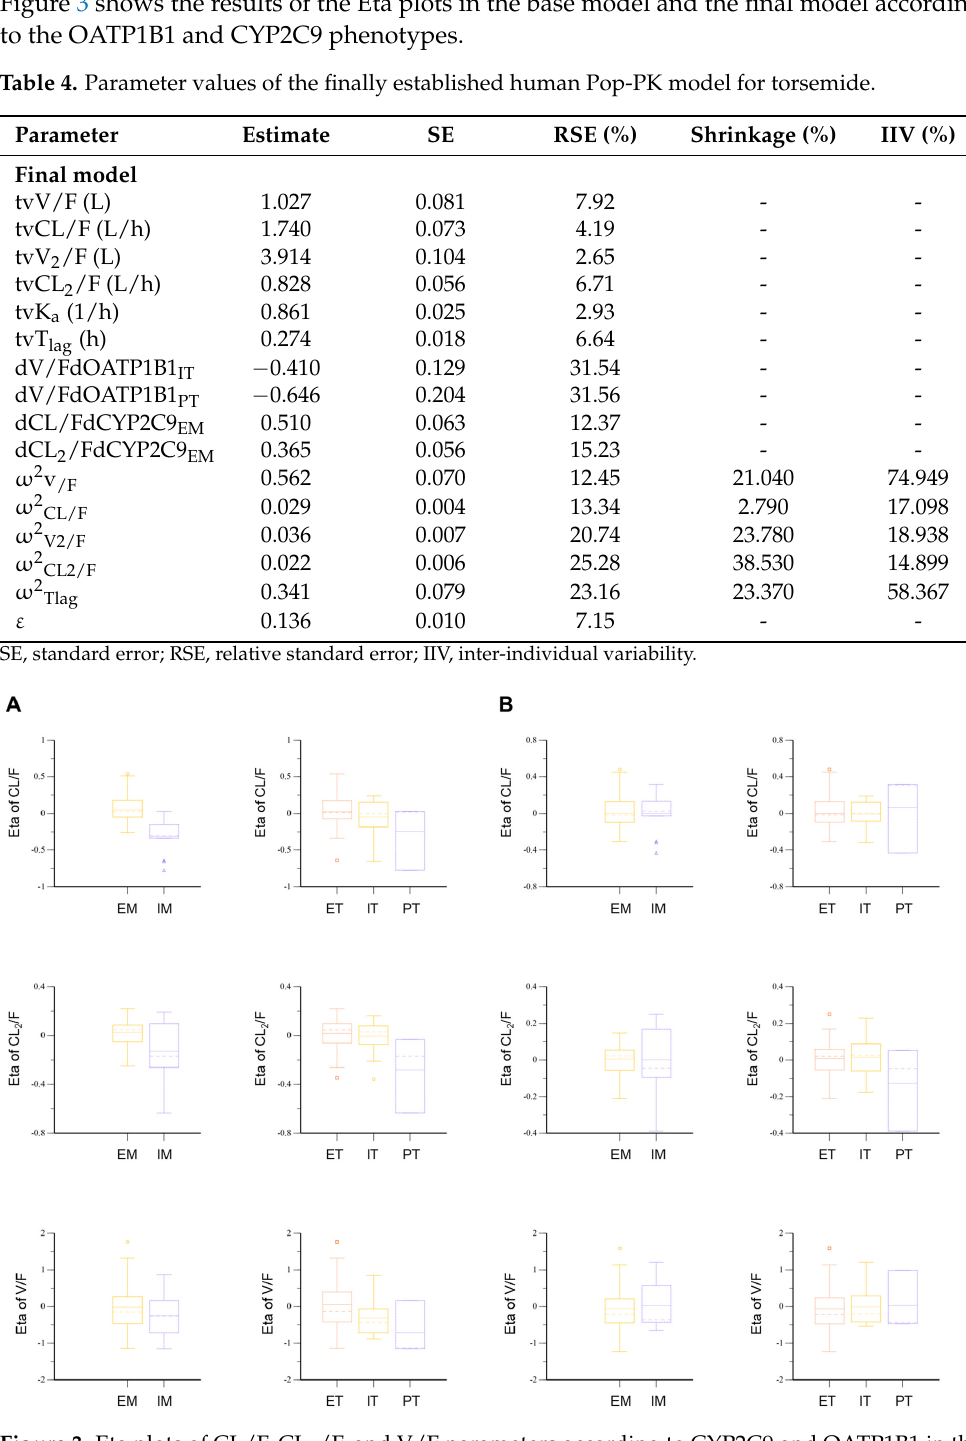
Figure 3. Eta plots of CL/F, CL 2 /F, and V/F parameters according to CYP2C9 and OATP1B1 in the base model ( A ) and the final model ( B ) for torsemide. Table 4. Parameter values of the finally established human Pop-PK model for torsemide.